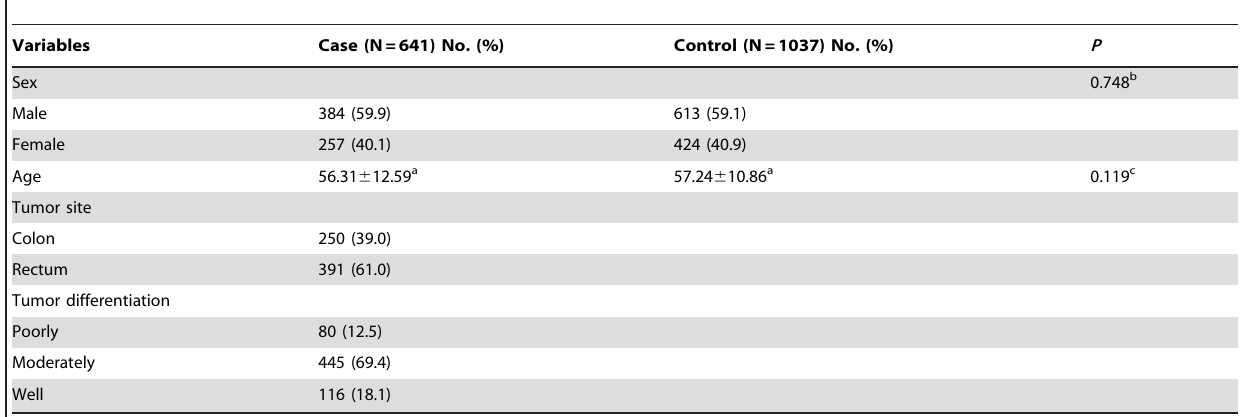
Table 1. The characteristics of the study